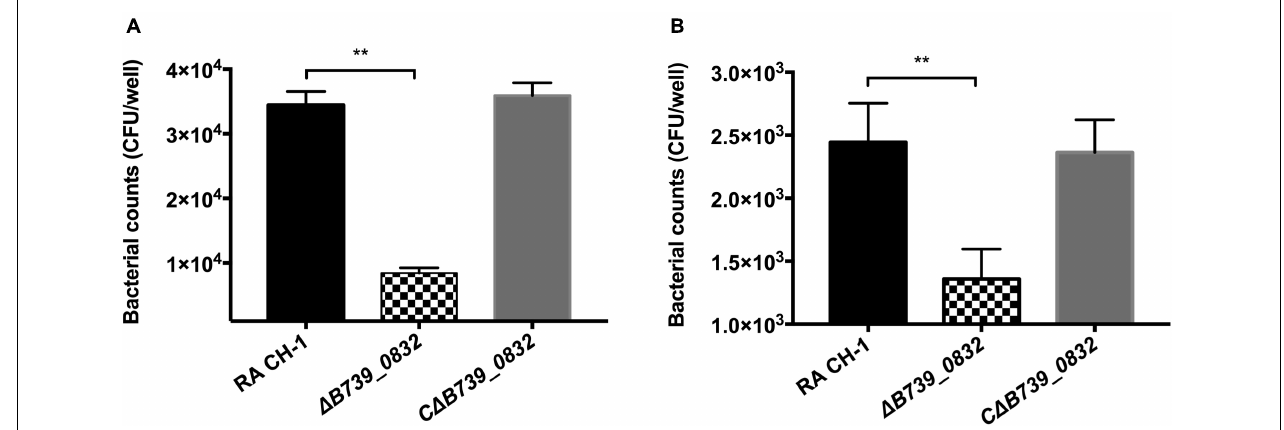
FIGURE 4 | Adherence and invasion assays for R. anatipestifer CH-1, (cid:49) B739_0832 , and C (cid:49) B739_0832 strains. Both adherence and invasion assay were performed using duck embryo fibroblast (DEF) cells. (A) Bacteria count from adherence assay measurements. (cid:49) B739_0832 showed significantly lower bacterial count, but maintained some level of host cell adherence ability. (B) Measurements of bacterial invasion ability. (cid:49) B739_0832 showed significantly lower host cell invasion ability, but did not completely abolish its invasion ability. All data were analyzed with Student’s t -test. Error bars represent standard deviation from three sets of independent measurements (** p <